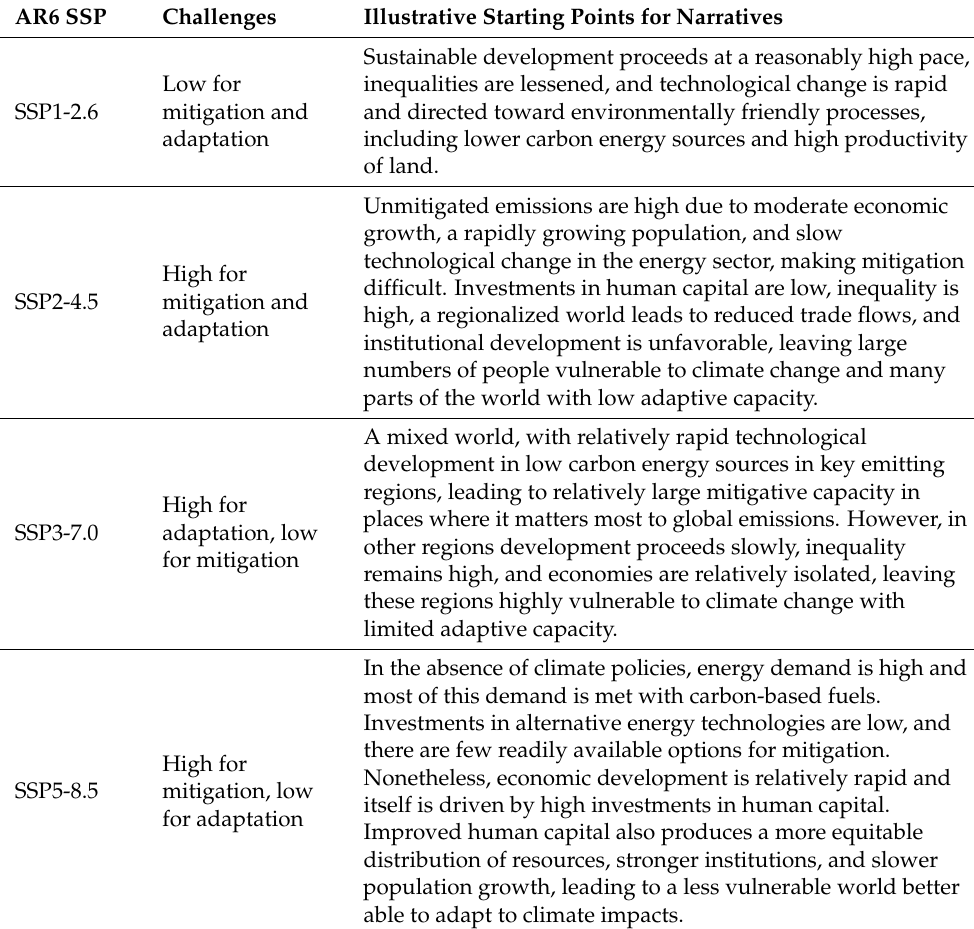
Table 3. Explain of AR6 climate change scenario from IPCC